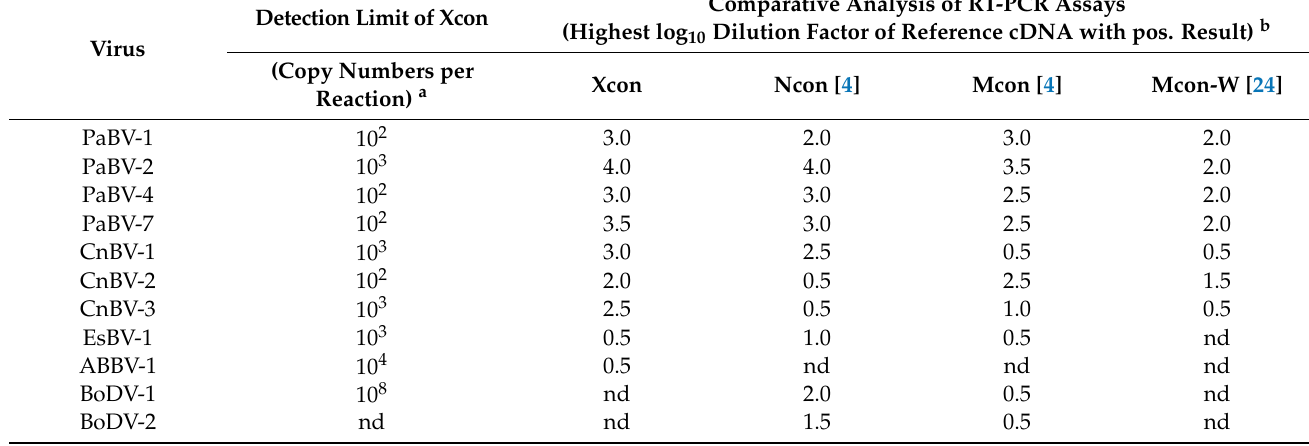
nd: not detectable. a Serial ten-fold dilutions of in vitro-transcribed X gene RNA with known copy numbers were analyzed. b Serial half-logarithmic dilutions of cDNA reverse transcribed from RNA samples of reference viruses were analyzed. Results are presented as means of two independent experiments.